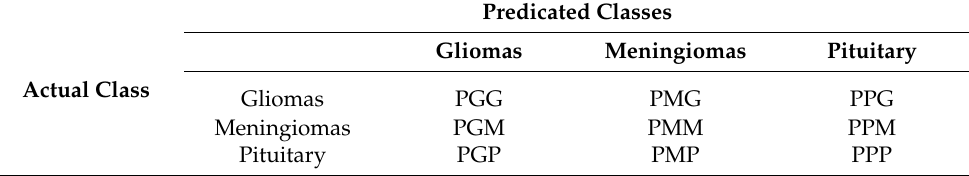
Table 4. General confusion